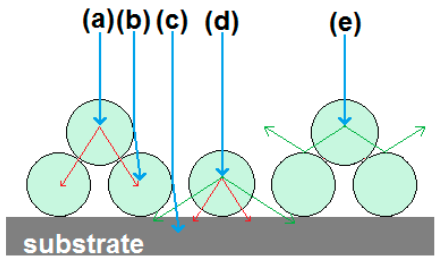
Figure 6. Effect of particle stacking in CL SEM images. Red rays are scattered primary electrons, green CL and blue the electron beam.